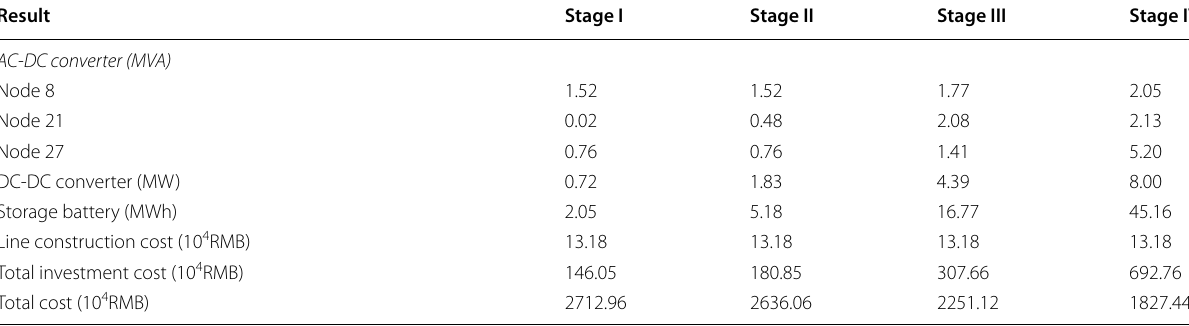
Table 6 Multi-stage planning results in Case III